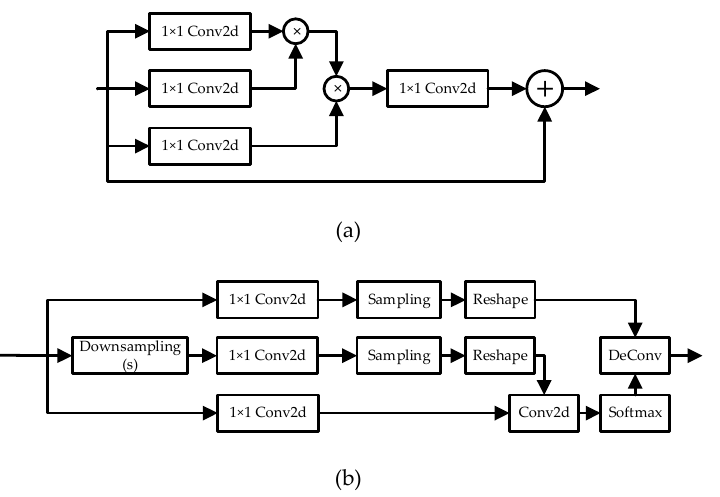
Figure 4. The detailed structure of non-local attention. ( a ) Non-local attention, ( b ) Cross-scale non-local attention.